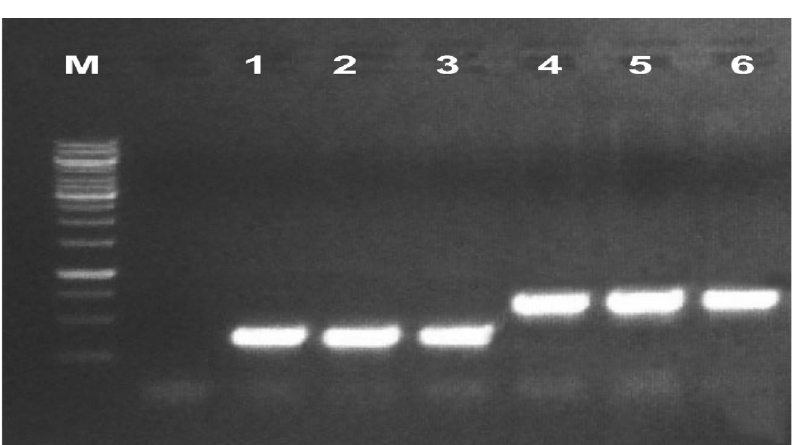
Figure 5. PCR amplification of both cry genes from transformed cotton. M: 10 kb molecular weight marker, Lane 1, 2, 3: show cry3Bb1 gene. Lanes 4, 5, 6: show cry3